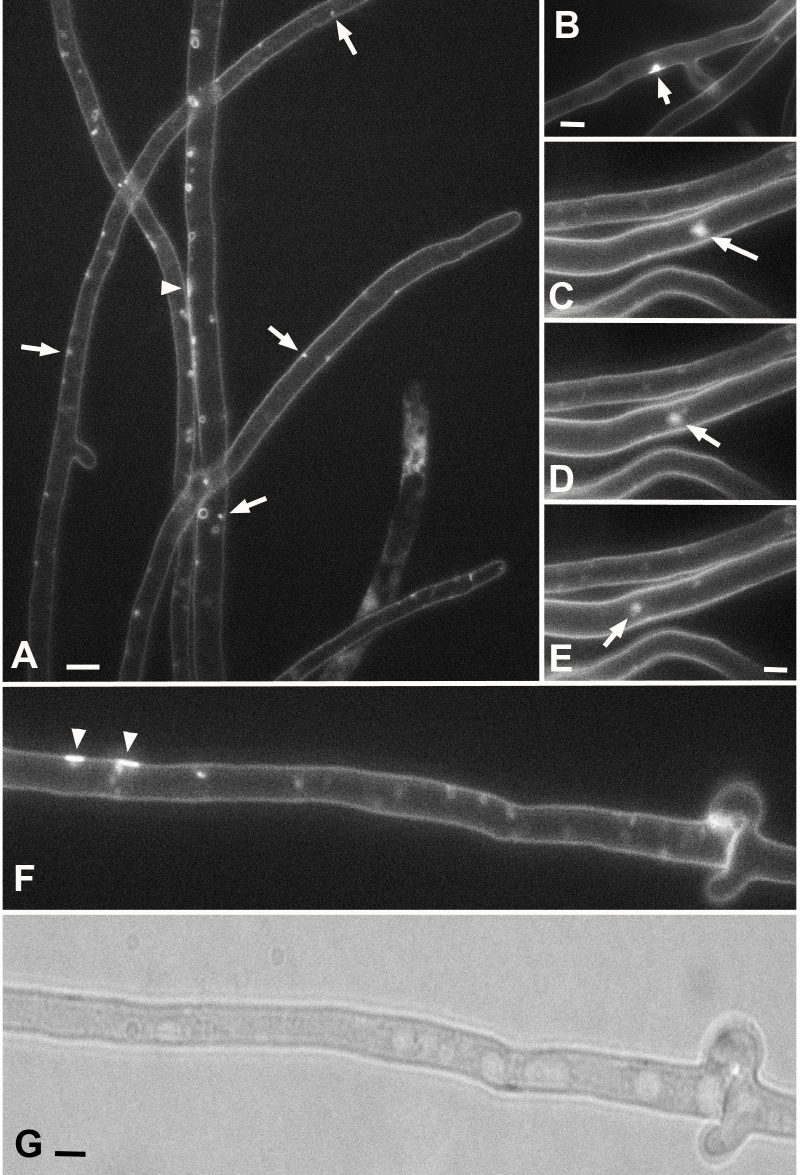
Figure 2. Glomeruli, pendants, and plaques in hyphae of O. olearius ( A ) and S. hirsutum ( B – G ). ( A )—arrows point to individual glomeruli, and the arrowhead points to plaque. ( B )—a large glomerulus is represented (arrow). ( C – E )—separate frames from Video S7, moving a large pendant. ( F , G )—fluorescent and bright-field images of one fragment of the hypha; plaques are marked with arrowheads. Scale bars are 5 µm.